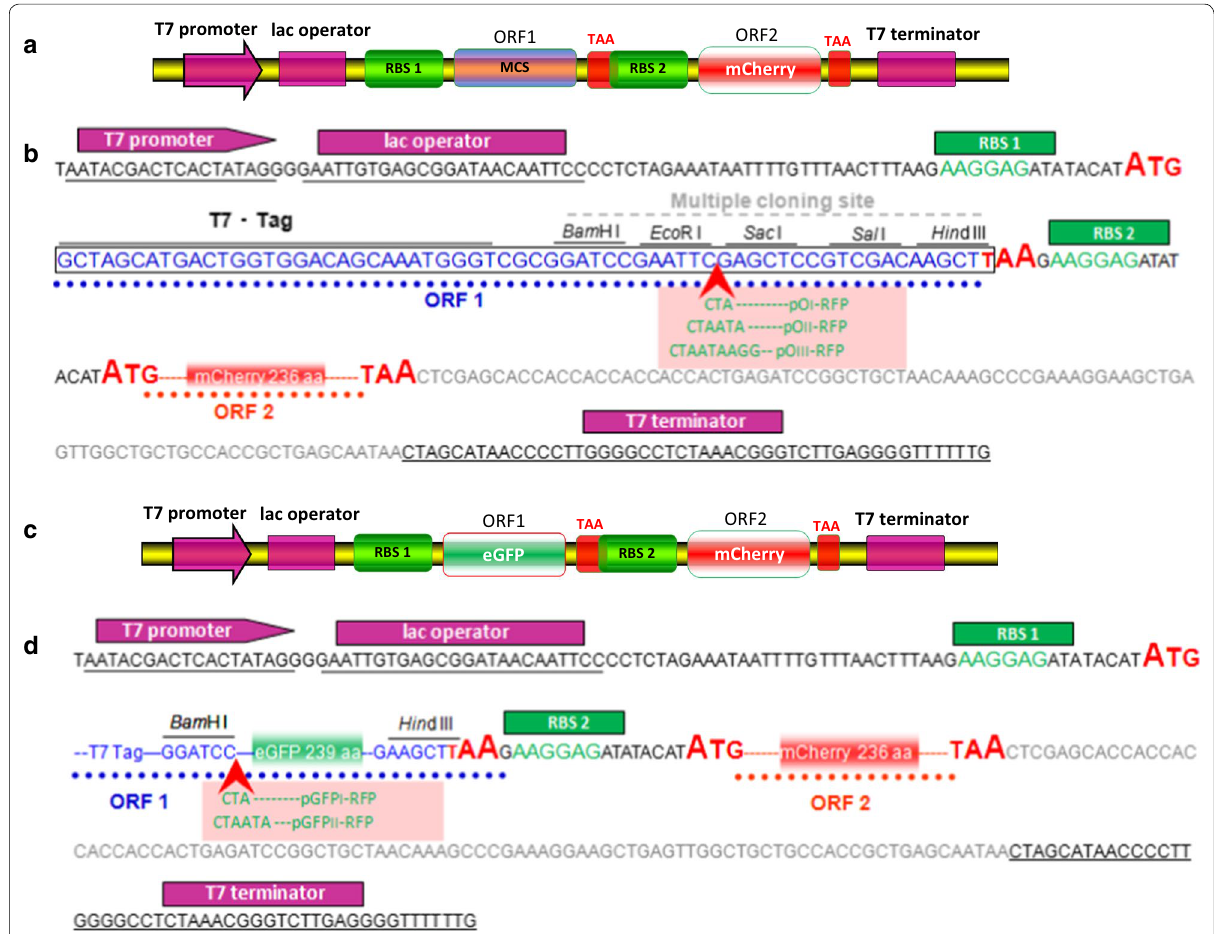
Fig. 1 Experimental design and DNA sequence of the dicistronic constructs used in this study. a Schematic diagram of the dicistronic expression vector pO‑RFP. RBS, ribosome‑binding site; MCS, multiple cloning sites; ORF, open reading frame. b pO‑RFP cloning/expression region. One/two/ three consecutive rare codons were introduced into ORF1 of pO‑RFP after Eco RI site, generating pOI‑RFP/pOII‑RFP/pOIII‑RFP vector. c Schematic diagram of the dicistronic expression vector pGFP‑RFP. The DNA fragment containing the eGFP coding sequence was directly ligated in pO‑RFP previously digested with Bam HI and Hin dIII. d pGFP‑RFP cloning/expression region. One/two consecutive rare codons were introduced into ORF1 of pGFP‑RFP after Bam HI site, generating pGFPI‑RFP/pGFPII‑RFP